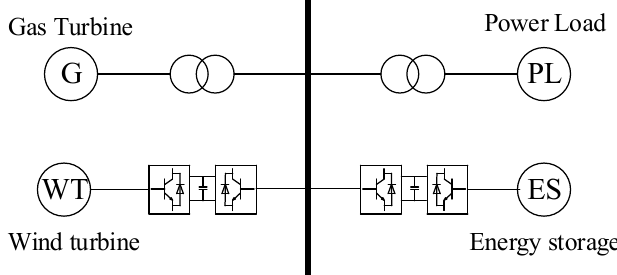
Figure 1. Microgrid system structure